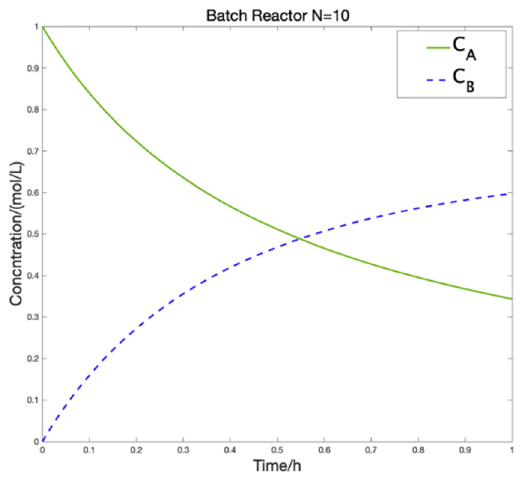
Figure 22. Optimal temperature control trajectory and iteration curve ( N = 10).